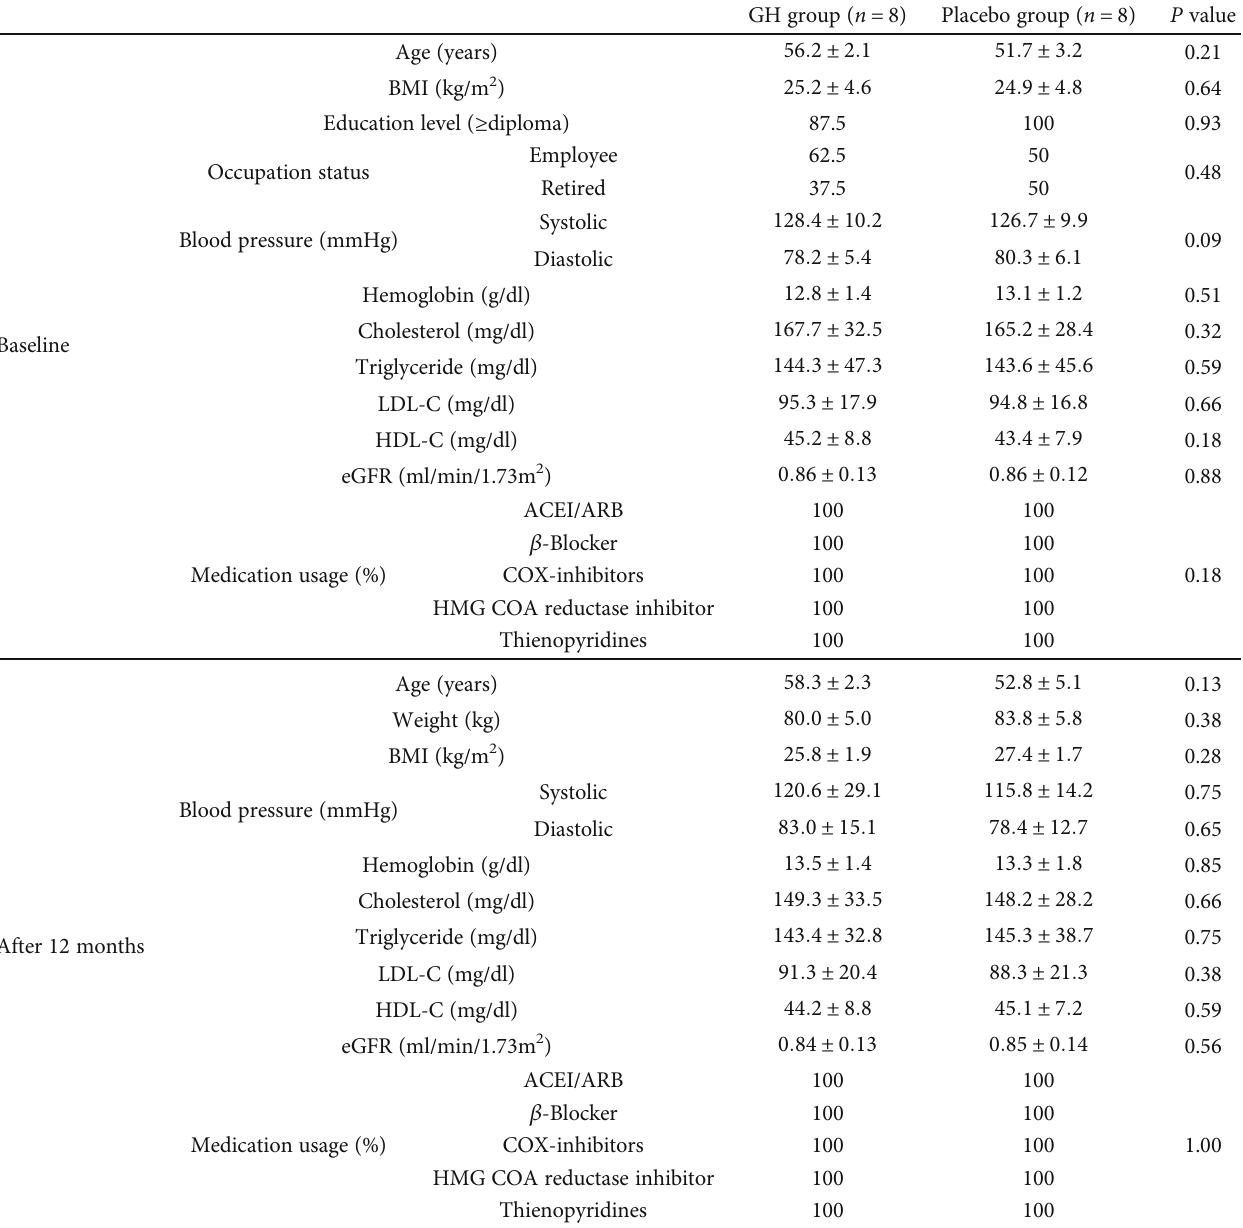
Table 1: Characteristics of study participants across di ff erent categories of intervention or control group at baseline and 12 months after study